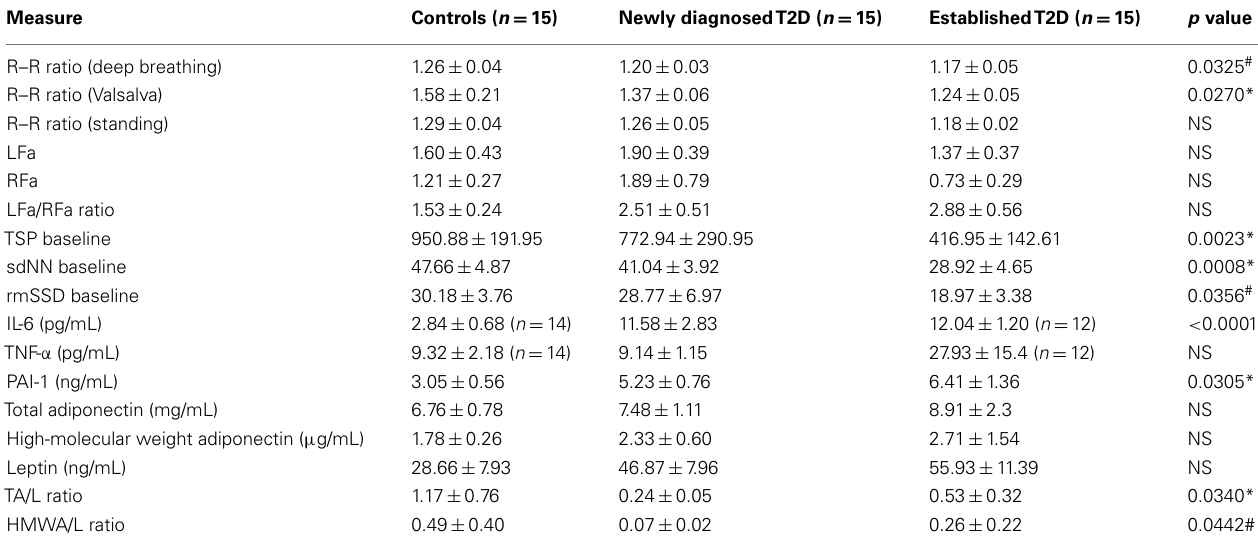
Table 3 | Measures of autonomic function and inflammation in healthy controls, newly diagnosed and established